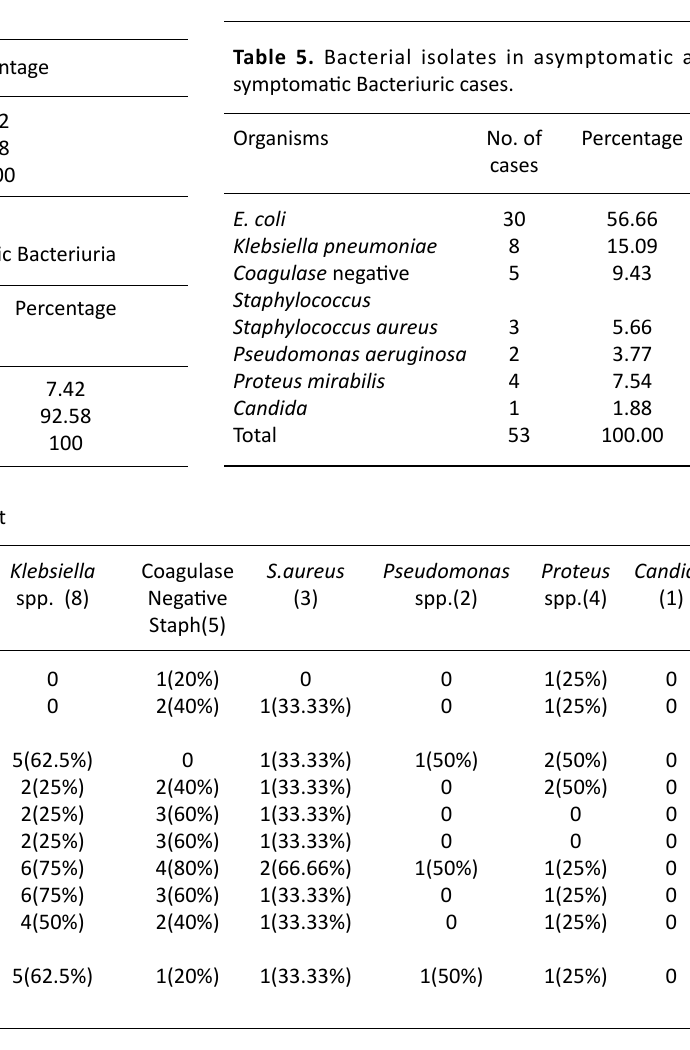
Table 2. Urine Microscopy for Symptomatic Pregnant